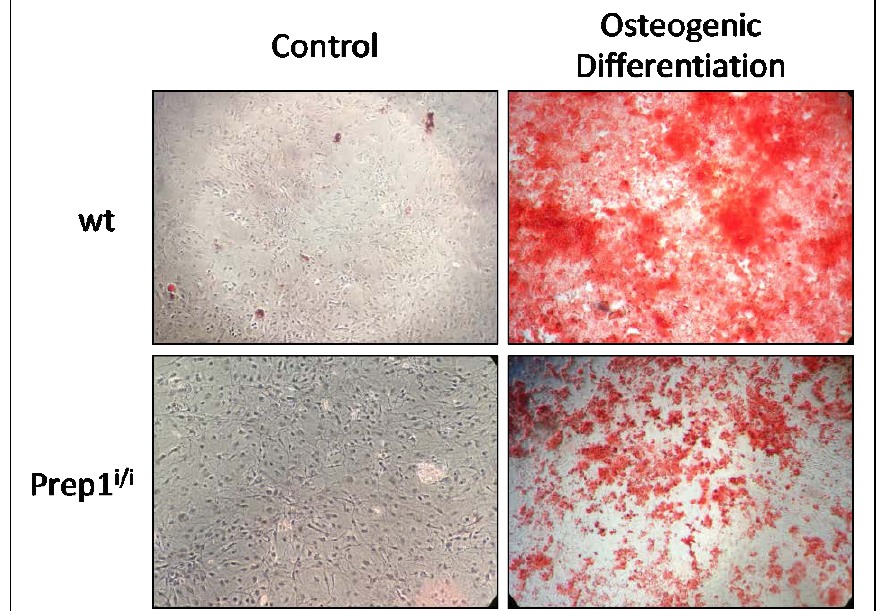
Figure 6. Alizarin Red O’Staining highlights altered osteogenic ability in culture Prep1 i / i cells. Staining is used to evaluate in culture osteogenic di ff erentiation e ffi ciency. Analysis has been performed on undi ff erentiated wt (upper left) and Prep1 i / i (lower left) cells as negative controls and on cells at terminal osteogenic di ff erentiation, wt (upper right) and Prep1 i / i (lower right). Red staining labels the extracellular matrix secreted by mature osteobalsts.